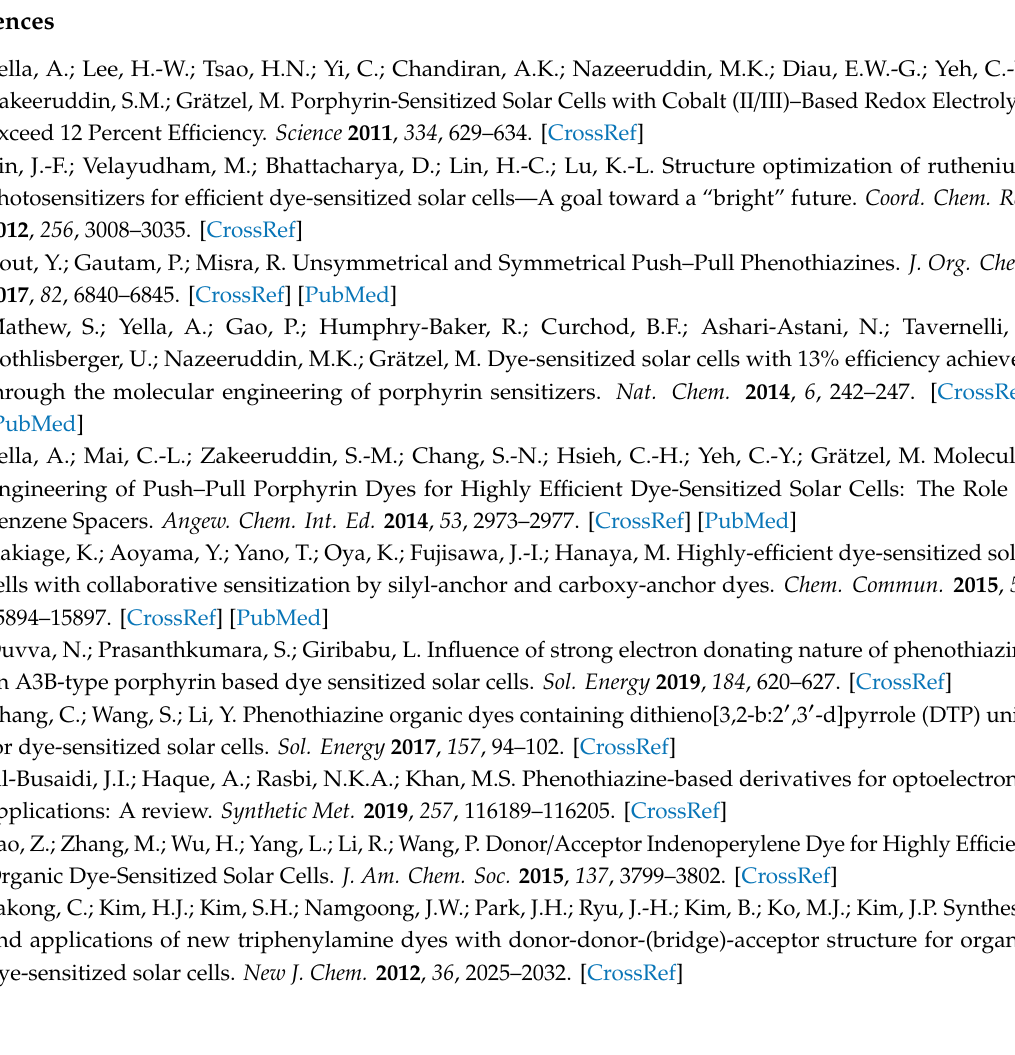
Figure S14: electrochemical properties of 2a–2c, Figure S15: combined IPCE spectra, Table S1: peak-to-peak separation data for